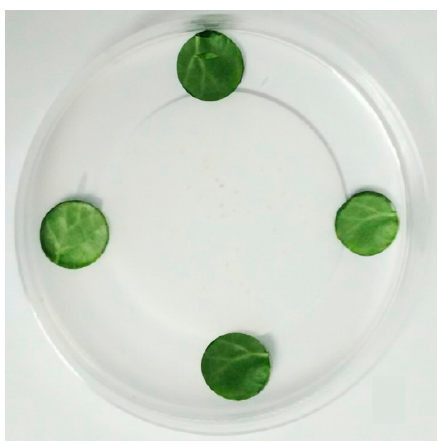
Figure 2. Layout of leaf discs of cotton in the Petri dish.